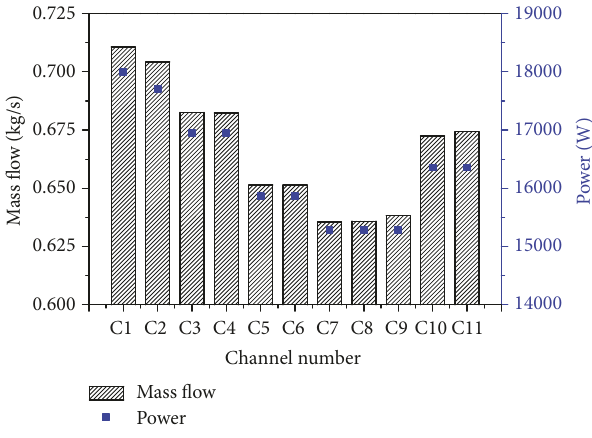
Figure 9: The mass flow and power in each fuel